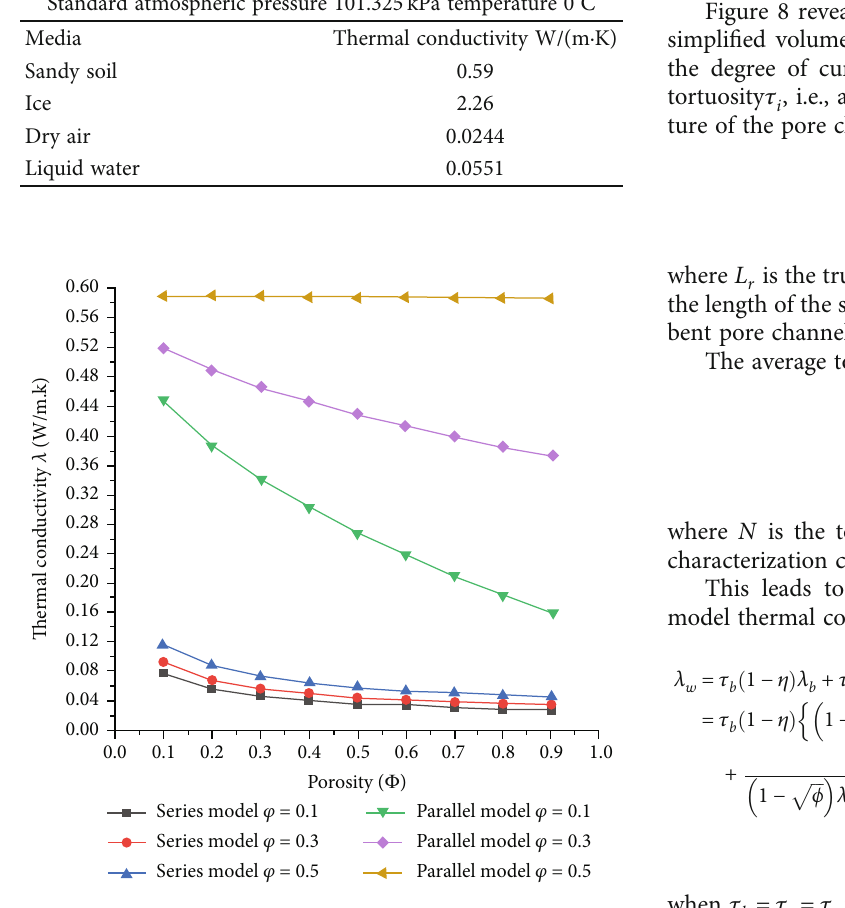
Figure 11: Relationship between thermal conductivity λ and porosity φ of simpli fi ed volume-weighted average REV model with di ff erent moisture percentage ϕ